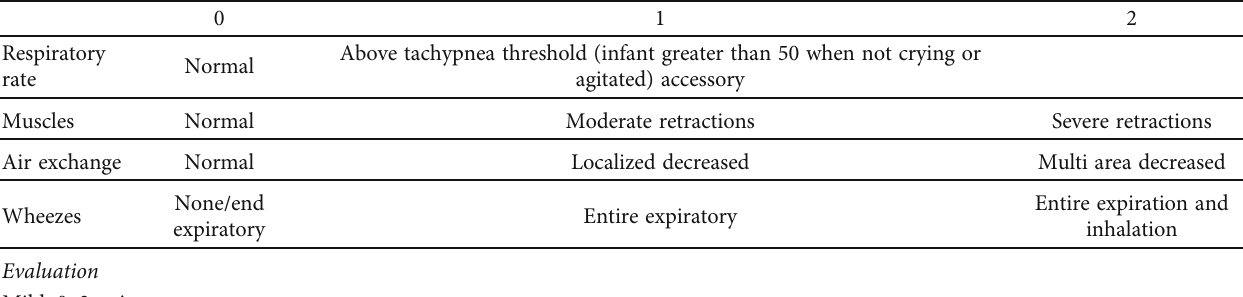
Table 1: The Modi fi ed Cincinnati Bronchiolitis Score (MCBS).